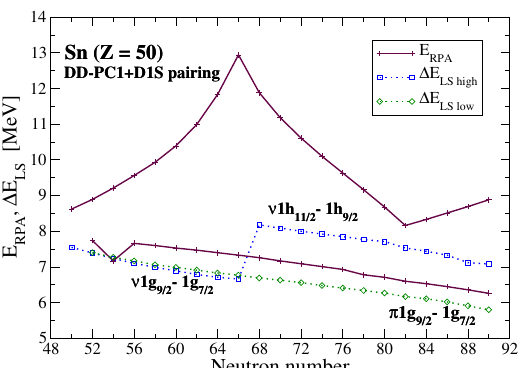
Figure 3. The M1-excitation energies in Sn isotopes and the corresponding SO-splitting energies ∆ E LS ((nlj) quantum numbers are denoted for the SO-partner levels). ∆ E LS